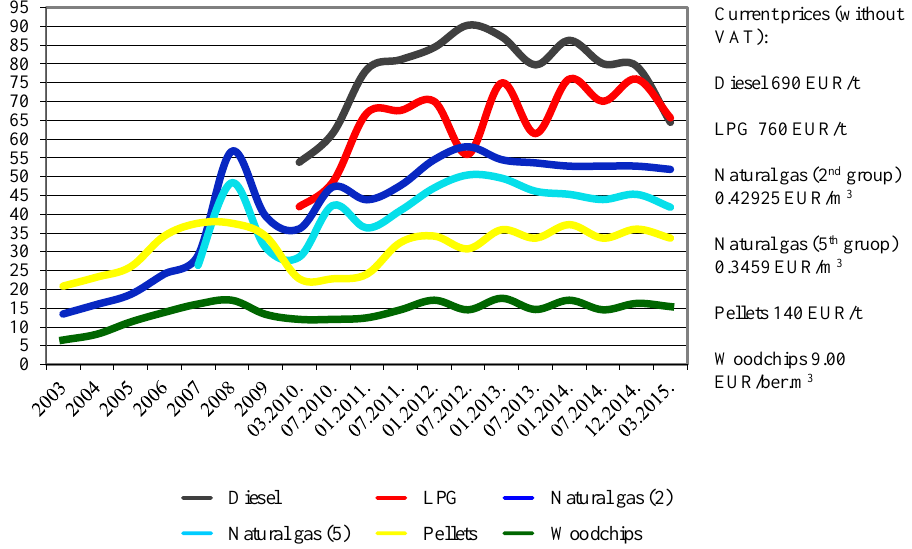
Fig. 5. Different fuel costs since 2003, taking into account efficiency coefficients of modern boiler